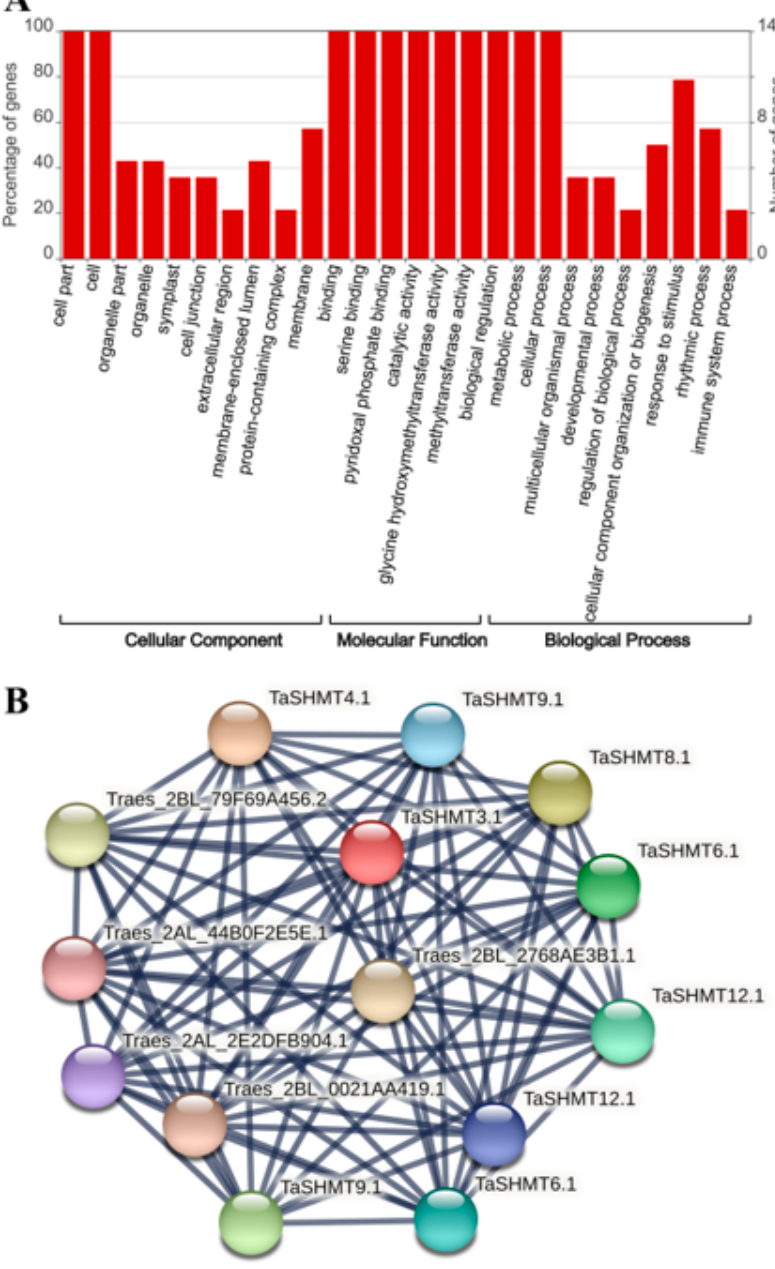
Figure 8. Gene ontology (GO) annotation ( A ) and protein–protein interactions ( B ) analysis of TaSHMT genes. ( A ) The GO terms are shown on the X axis, and the number of genes are shown on the Y